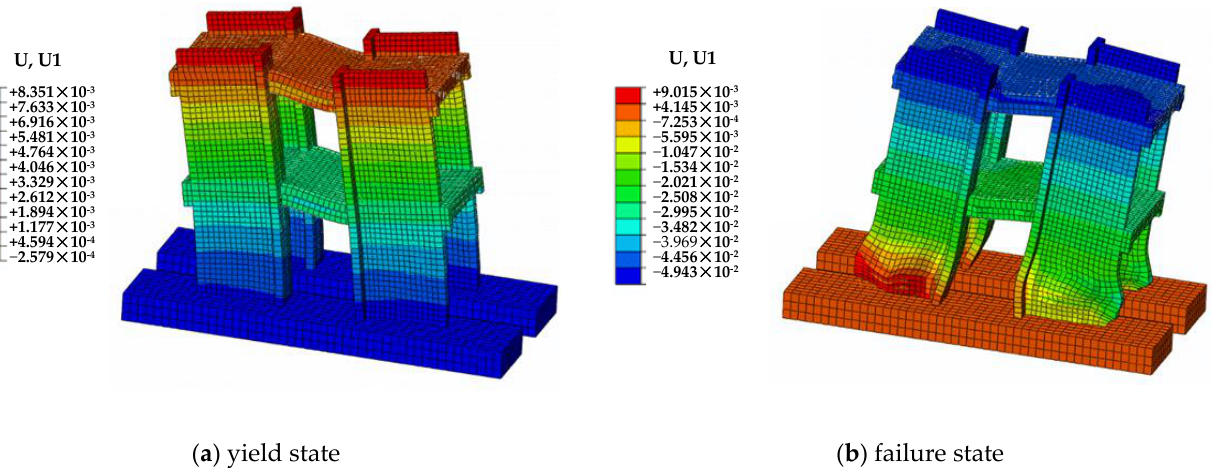
Figure 16. Horizontal displacement of the spatial structure specimen of the fabricated ECC/RC combined shear wall.